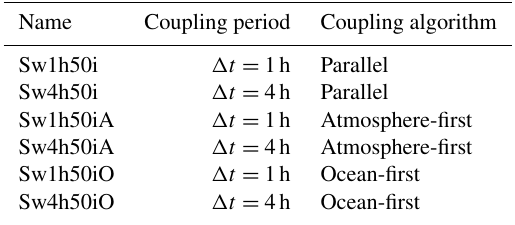
Table 2. Main characteristics of the